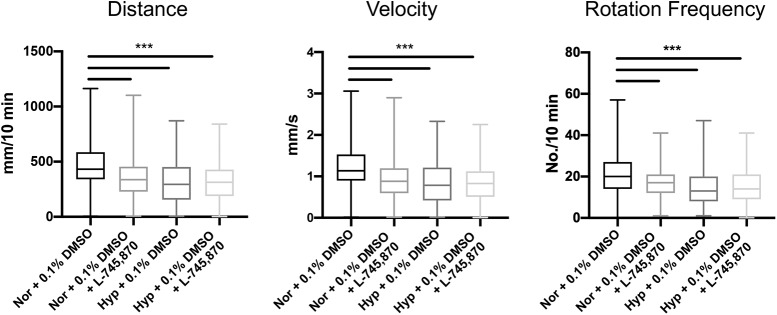
Dopaminergic antagonist exposure impairs zebrafish locomotor development similar to effects of hypoxia. Analysis of zebrafish larvae at 5 dpf, following exposure to L-745870 from 72 to 96 hpf. Impairments in distance, velocity, and rotation frequency (quantified data in Table 3). Each point is a separate animal. Mean shown, ANOVA; ***p < 0.001. Hyp, hypoxia; Nor, normoxia.